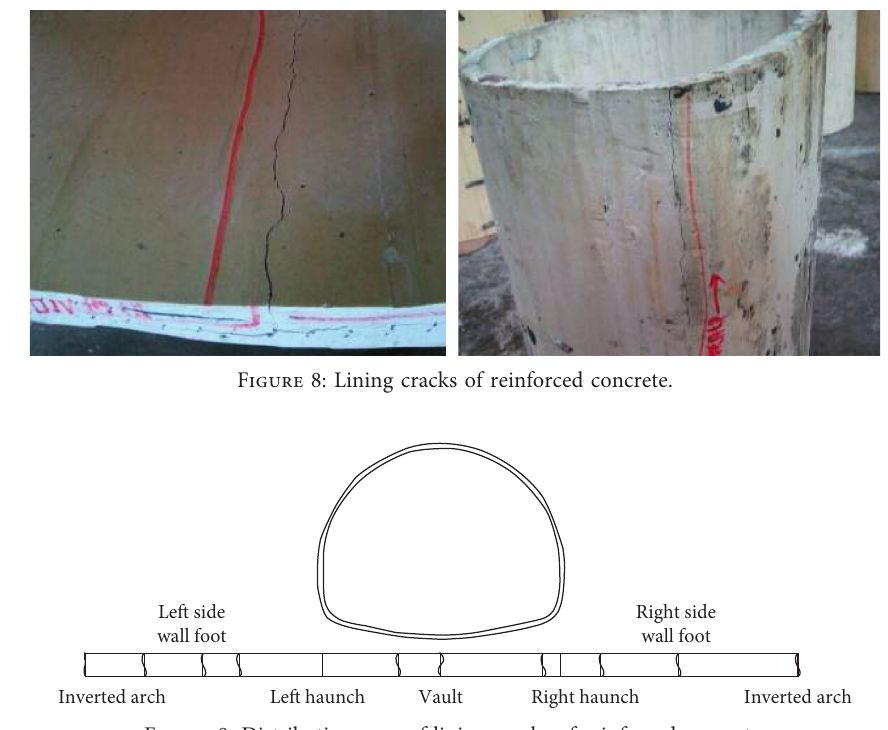
Figure 9: Distribution map of lining cracks of reinforced concrete.